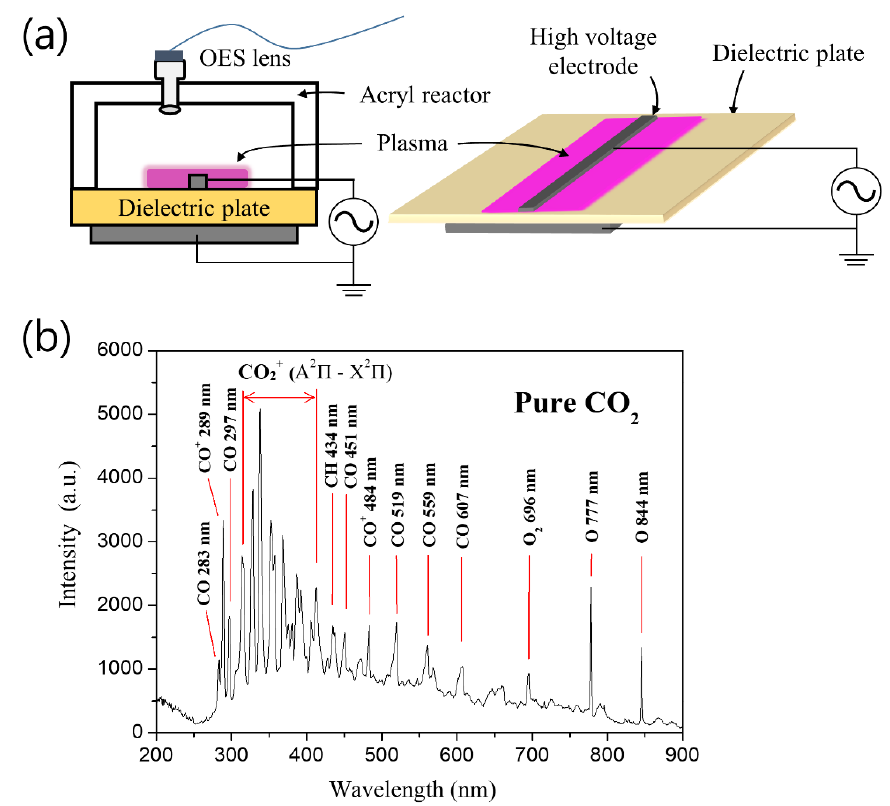
Figure 2. CO 2 optical emission spectroscopy (OES): ( a ) Schematic of the electrode for measuring OES, ( b ) representative measured CO 2 optical emission spectrum of the dielectric-barrier discharge (DBD) electrode at 11.5 kV peak to peak.